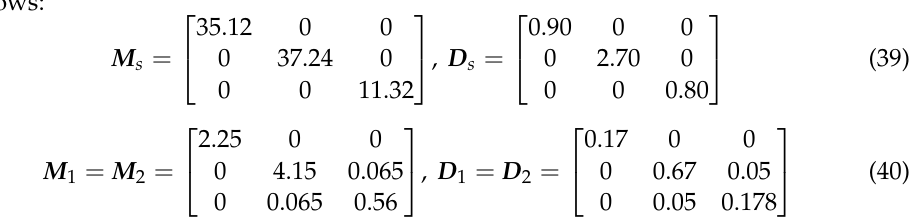
Table 1. The specifications of the barge ship and tugboats.